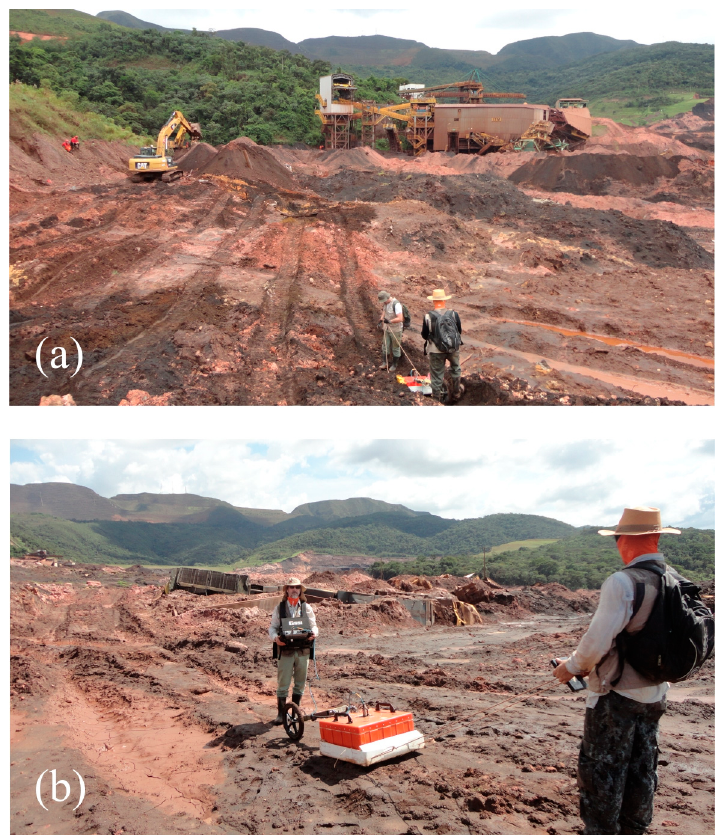
Figure 4. Acquisition of GPR profiles with SIR-4000 equipment and 200-MHz shielded antennas (GSSI) on the tracks left by the excavating machine in area 1 ( a ) and area 2 ( b ).